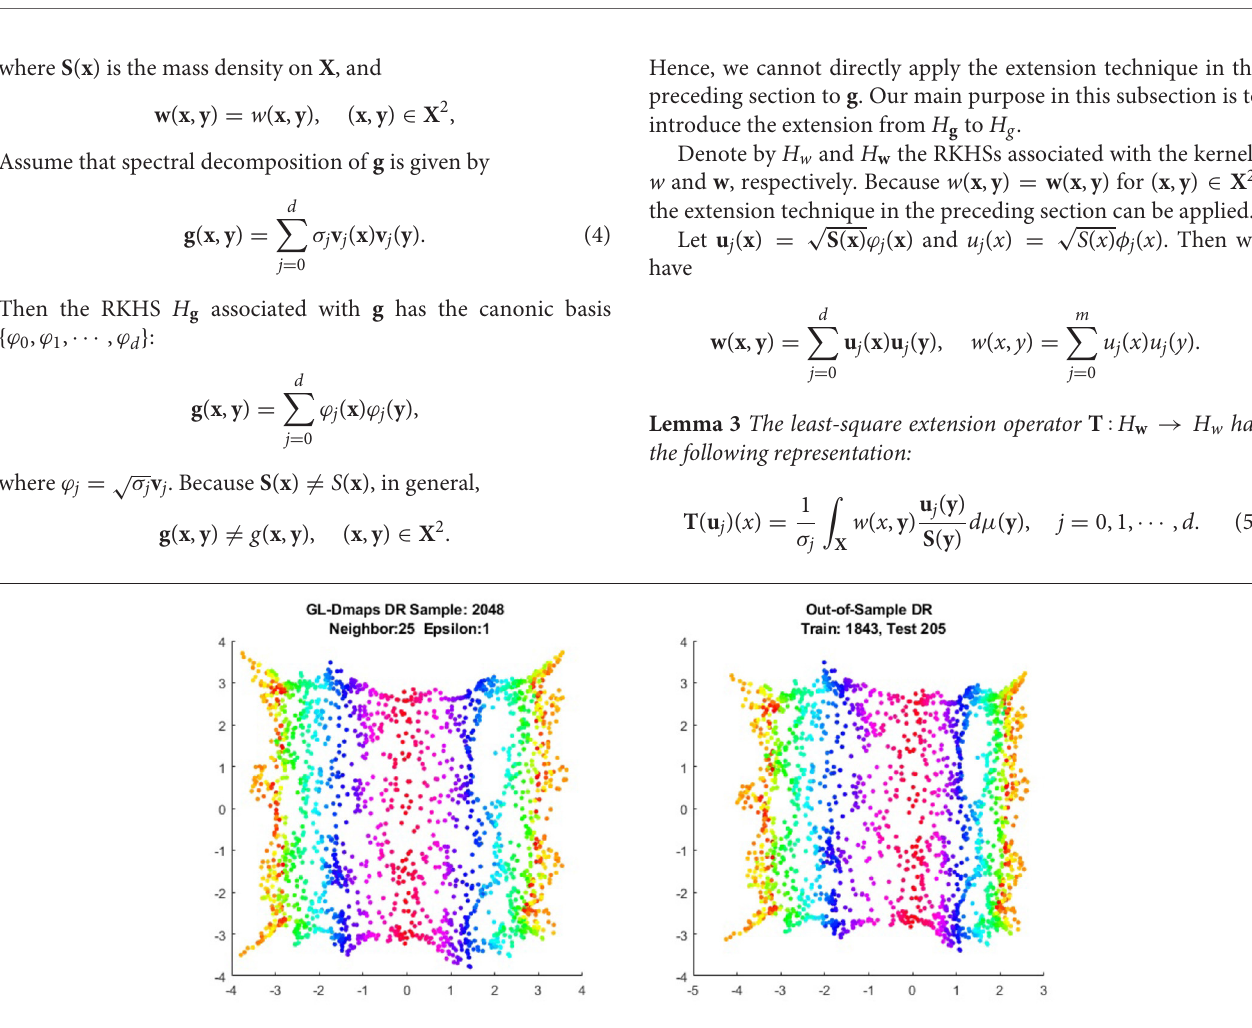
FIGURE 2 | GL out-of-sample extension for DR of S-Curve.